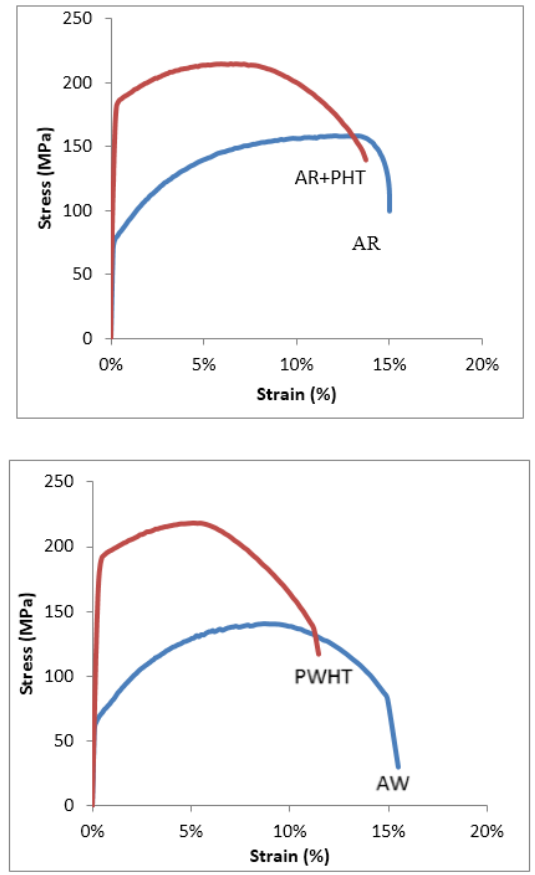
Figure 7. Stress versus strain response of 6.4 mm (1/4 in) thick AA6063 in the as-received (AR), as-received plus precipitation heat treated (AR+PHT), as-welded (AW) and post weld heat treated (PWHT) conditions.